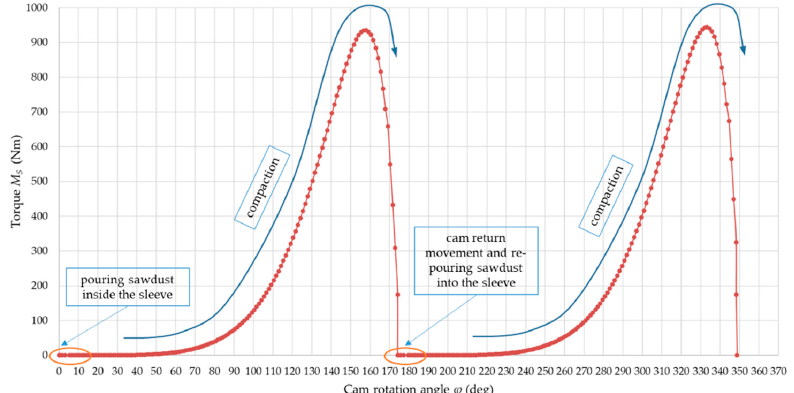
Figure 18. Change of torque M s required in the course of the compaction cycle for the biomass in the form of oak sawdust as a function of the cam rotation angle φ .